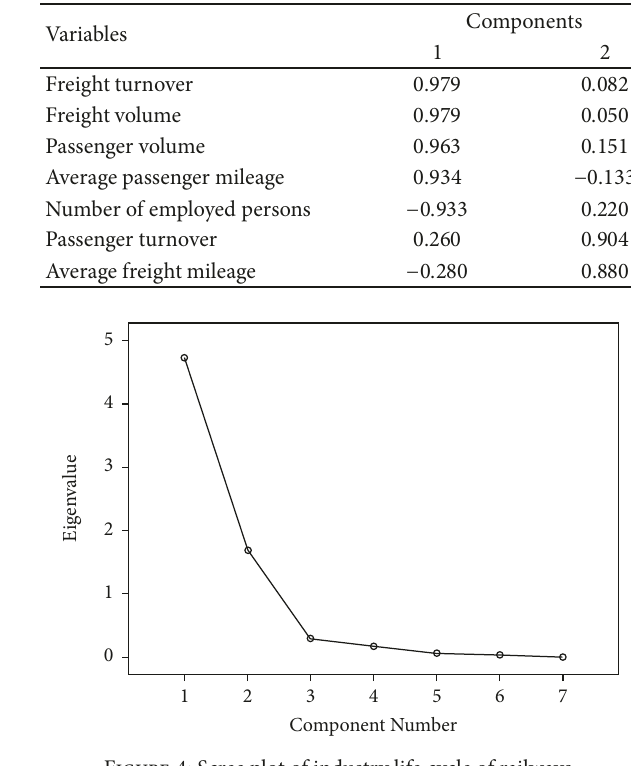
Figure 4: Scree plot of industry life cycle of